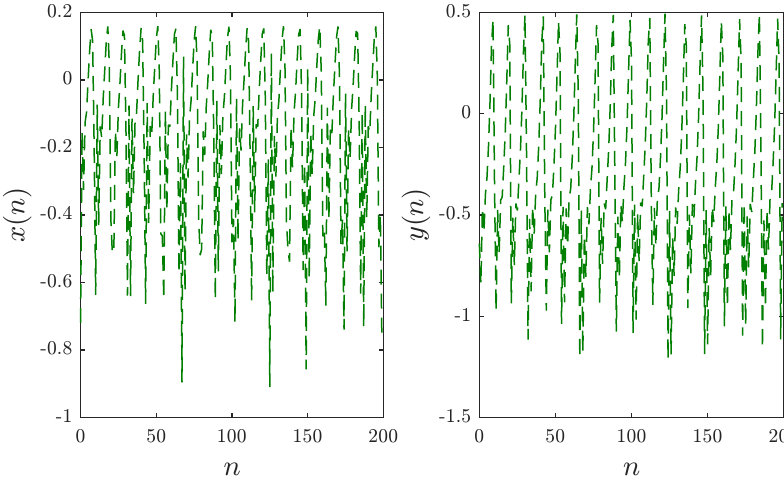
Figure 2. Time evolution of the fractional Tinkerbell map’s states with parameters ( α , β , γ , δ ) = ( 0.9, − 0.6013,2,0.5 ) , initial conditions ( x ( 0 ) , y ( 0 )) = ( − 0.72, − 0.64 ) , and fractional order υ = 0.98.